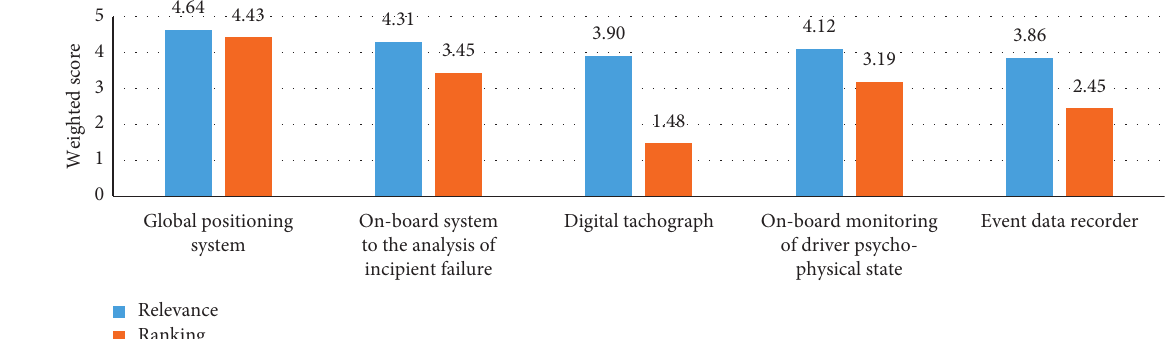
Figure 13: Weighted mean of relevance and priority ranking related to Question C1.